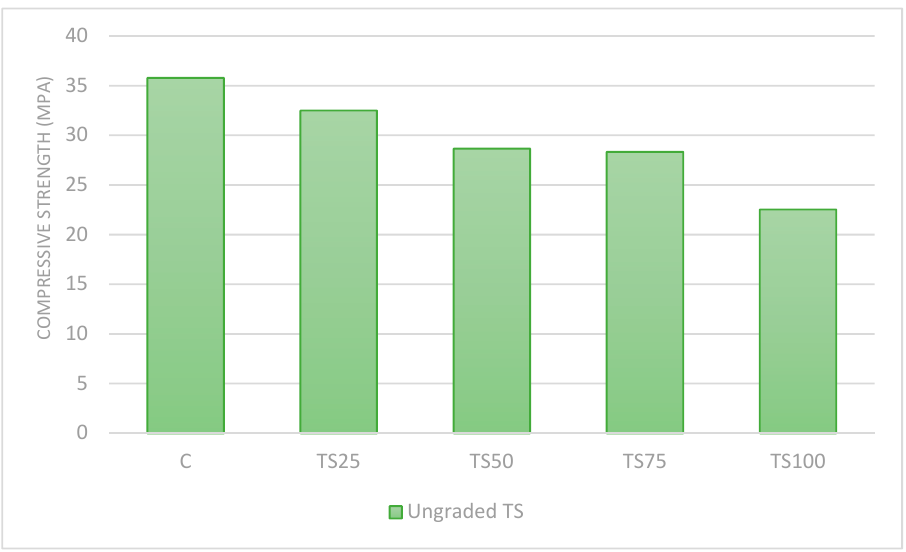
Figure 12. The 28-day compressive strength of ungraded TS mortars at a w / c of 0.55. The control mortar had the highest compressive strength of 35.78 MPa, whereas TS25, TS50, TS75, and TS100 had compressive strengths of 32.51 MPa, 28.67 MPa, 28.33 MPa, and 22.54 MPa, respectively. This shows that the effect of the TS aggregate in terms of bond improvement in graded TS was not seen in the ungraded TS. This was due to inadequate distribution of aggregates within the matrix because larger aggregates dominate as TS replacement increases. Consequently, more pores are formed within the matrix and the progressive compressive strength